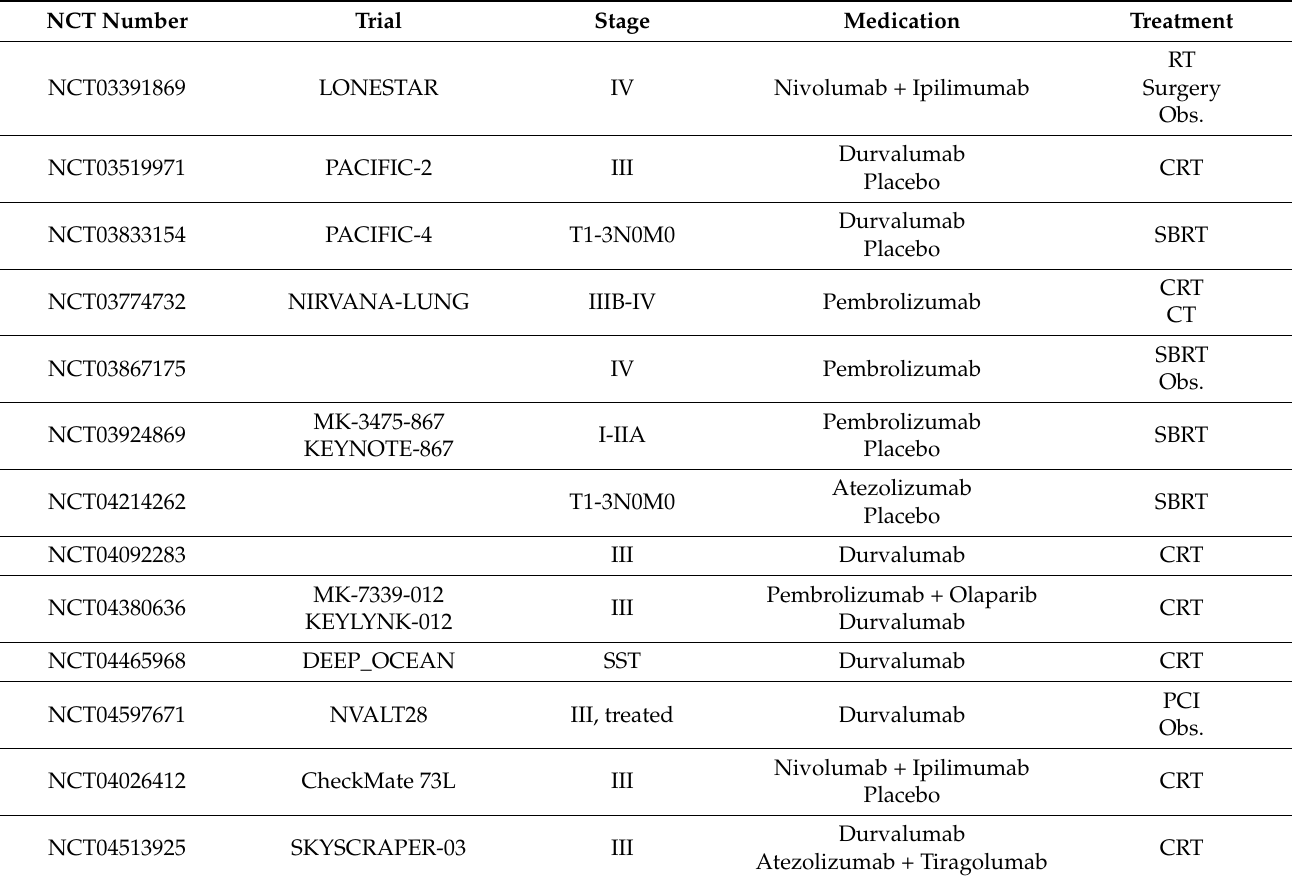
Table 1. Summary of ongoing phase 3 trials of immunotherapy combined with chemoradiotherapy for lung cancer (ClinicalTrials.gov, accessed on 27 April